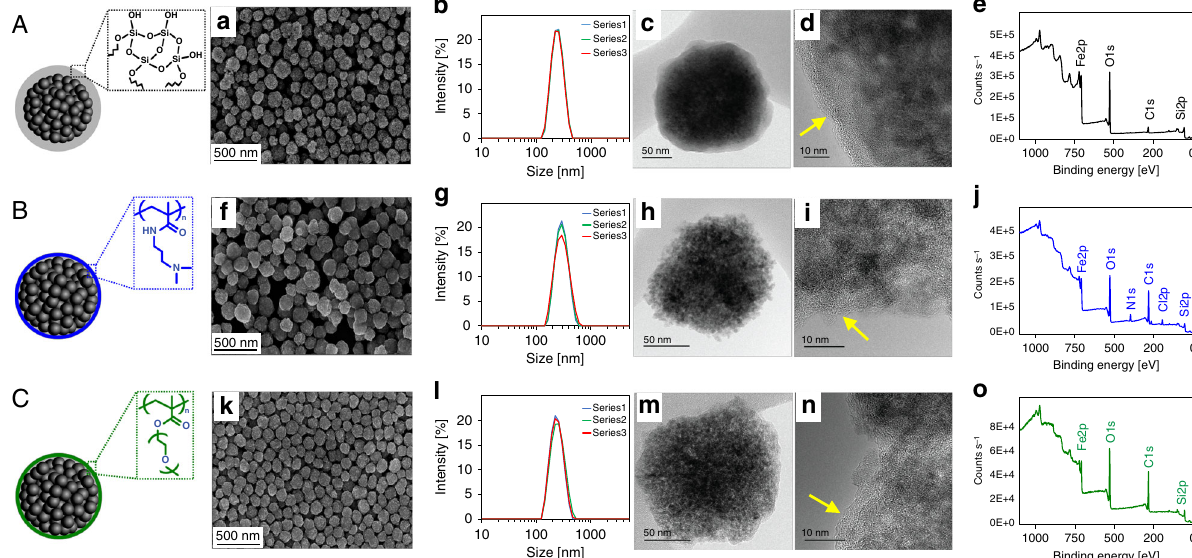
Fig. 2 Characterization of the three SPIONs. A SP-003, B SP-007, and C SP-011, by a , f , k SEM, b , g , l DLS, c , h , m TEM, d , i , n HRTEM, and e , j , o XPS, respectively. DLS shows three replicates of each NP. Panels d , i , and n show the HRTEM pictures recorded at the surface of individual SP-003, SP-007, and SP-011 NPs, respectively, and the yellow arrow points to the region of d amorphous SiO 2 coating and i , n amorphous SiO 2 /polymer coatings on the NP surface. Source data are provided as a Source Data fi